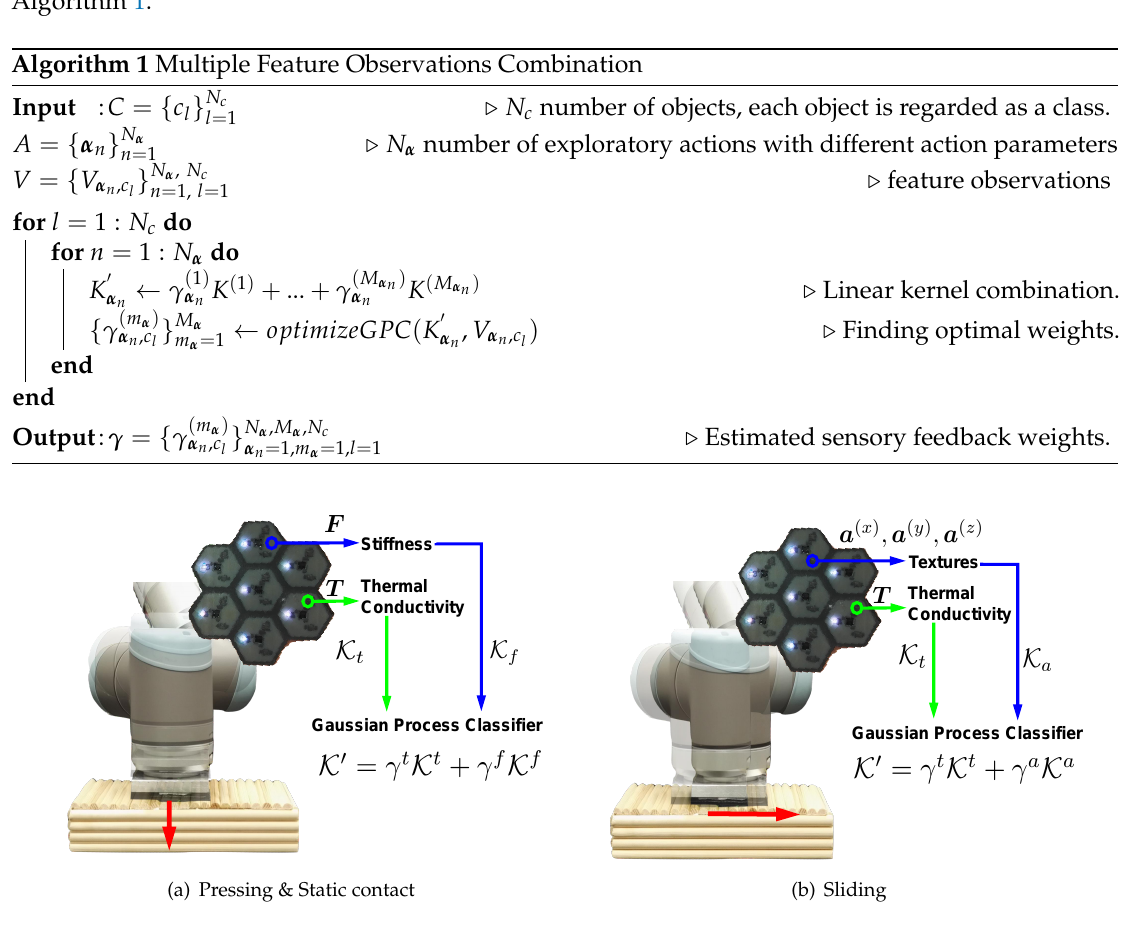
Figure 5. Illustration of multiple feature observations combination method. ( a ) The robotic system combines the normal force sensing and temperature sensing to learn about objects by applying pressing and static contact movements; ( b ) The robot slides on the object surface to sense its textural property and thermal